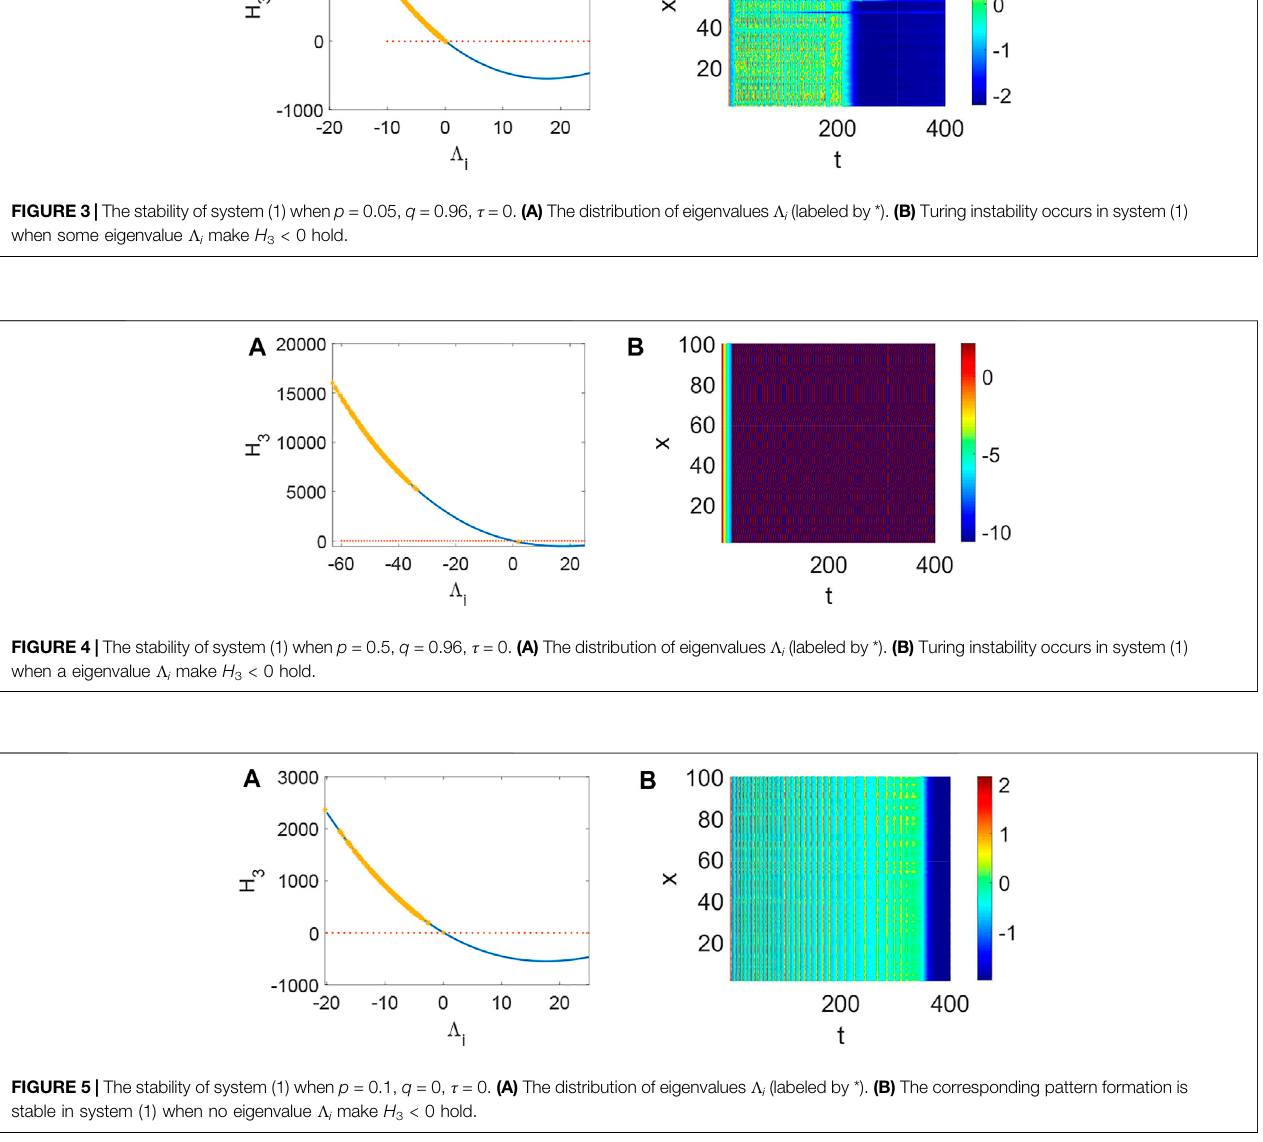
Frontiers in Physiology |